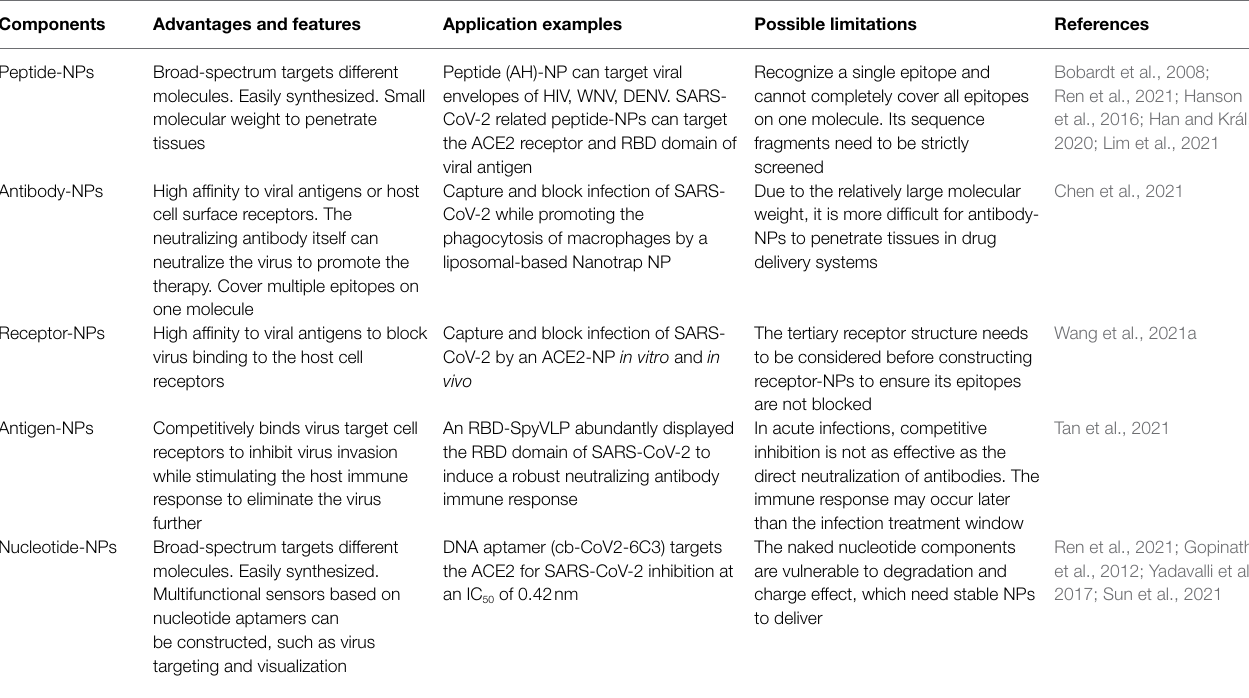
TABLE 1 | Summary of the functionalized NPs in targeted therapy of viral infections.